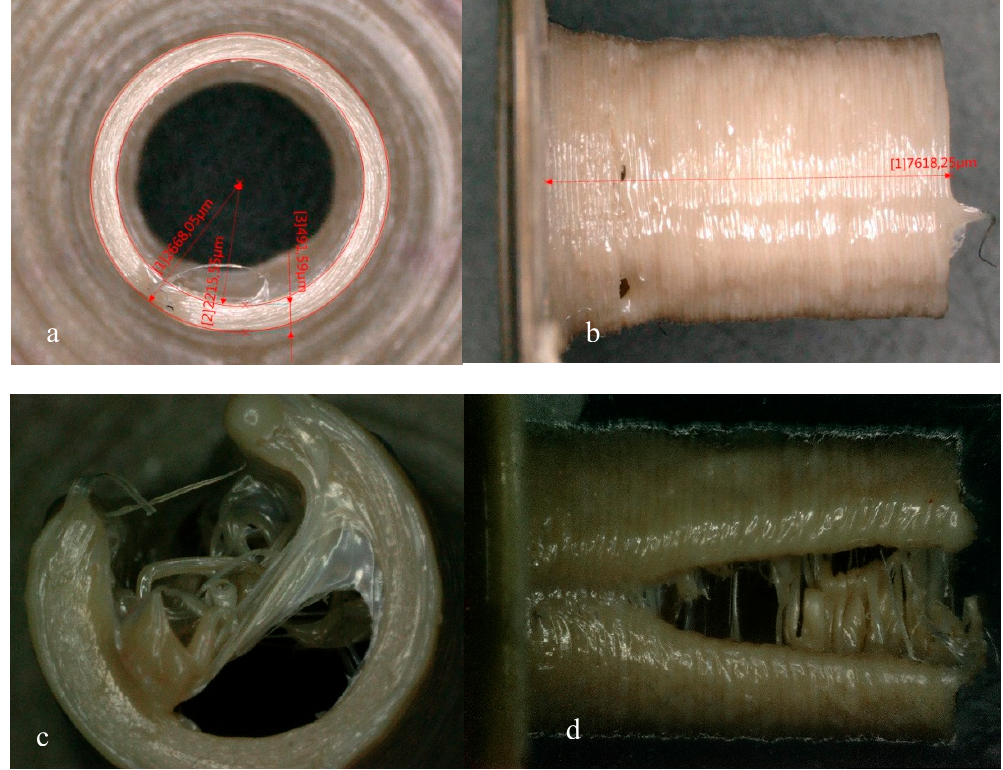
Figure 5. Barrels printed with radius of 3 mm and wall thickness of 0.5 mm by Apium HPP155 with two software. ( a , b ) Samples printed by software installed in the printer, and ( c , d ) are printed by Simplify 3D, respectively.